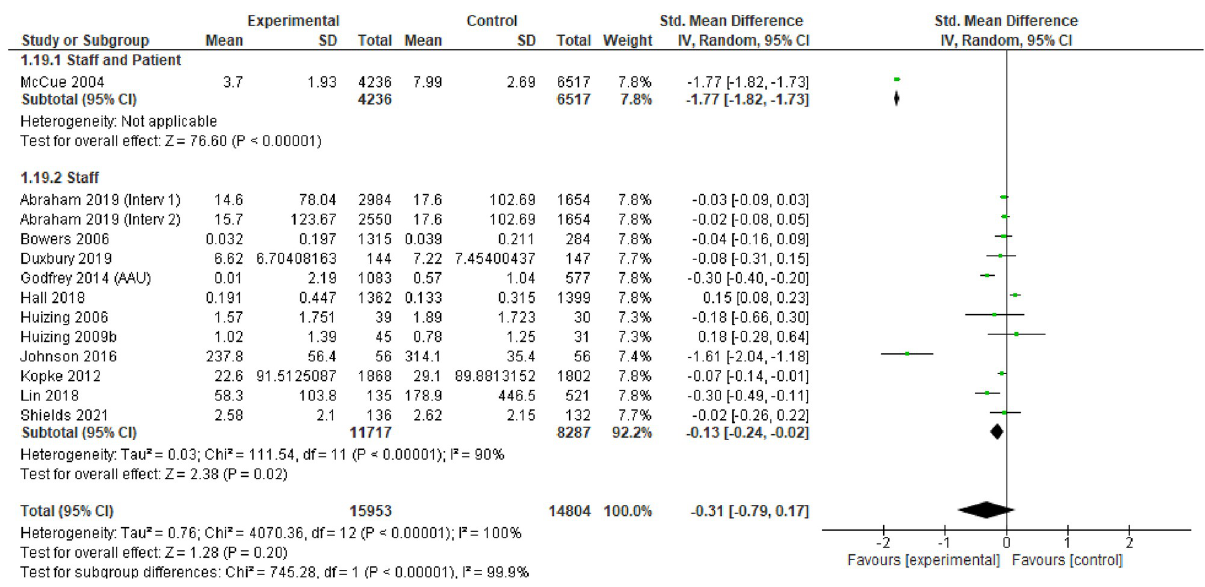
Fig 8. Effectiveness of interventions on the use of restraint by those receiving the intervention, excluding outliers.